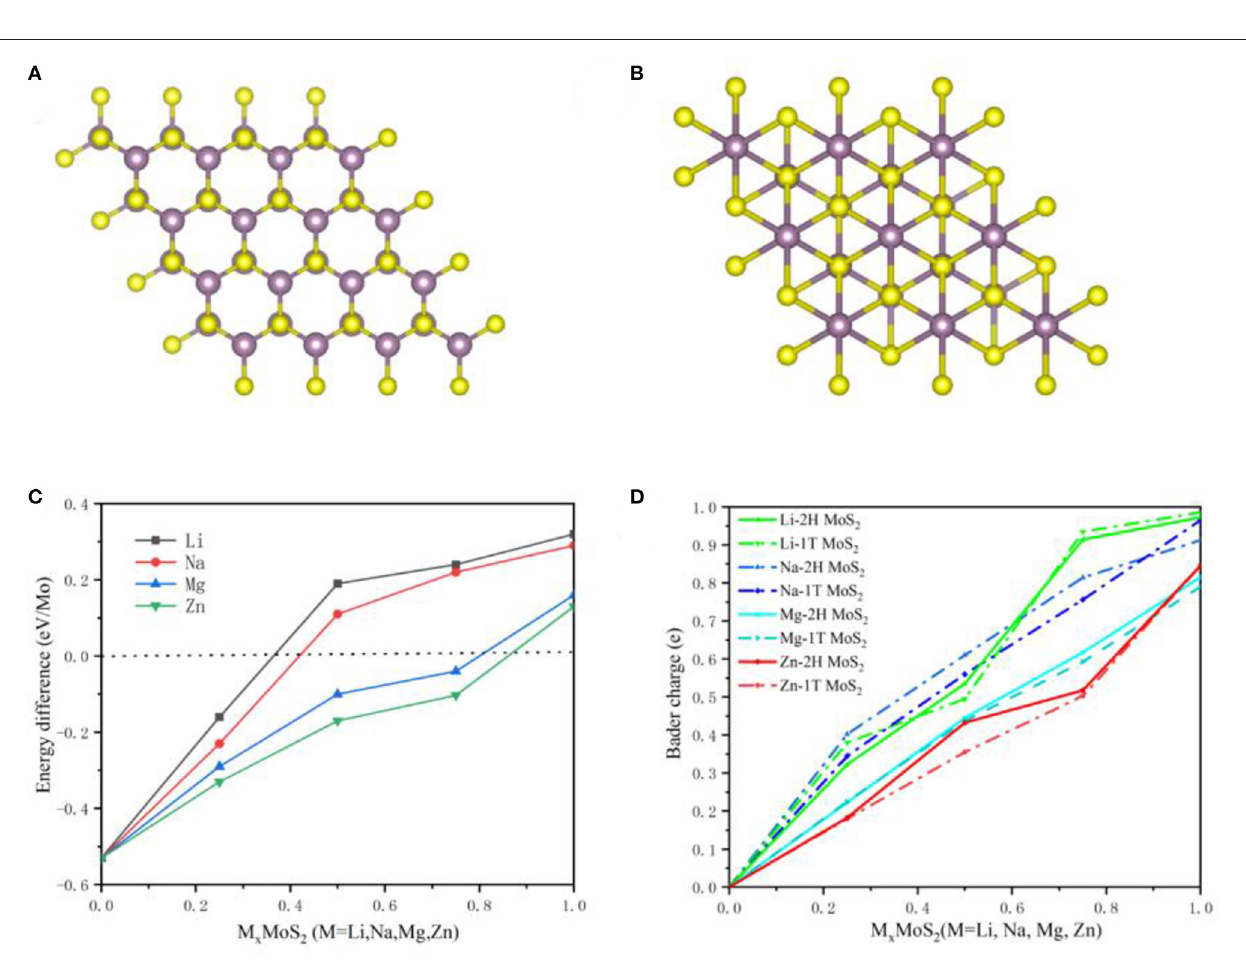
FIGURE 9 | The 2H (A) and 1T (B) for MoS 2 anodes structure. (C) Energy difference between the 2H and 1T structure of MoS 2 with Metal ions concentration and (D) Charge transfer with M-ions concentration in 2H and 1T MoS 2 structure.